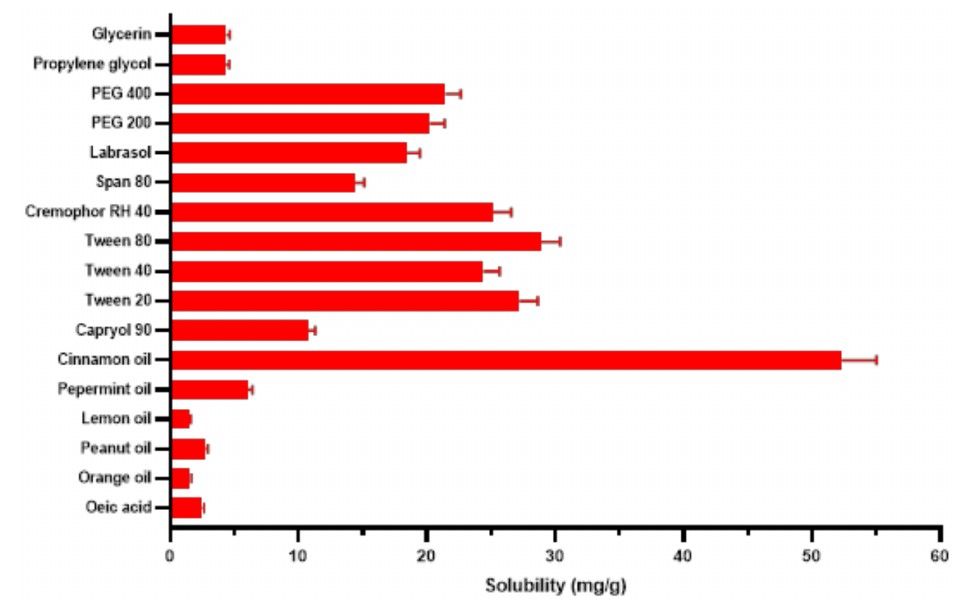
Figure 2. Tadalafil solubility in different oils, surfactant, and co-surfactants. Table 3. Screening of surfactants and cosurfactants for oil emulsification.